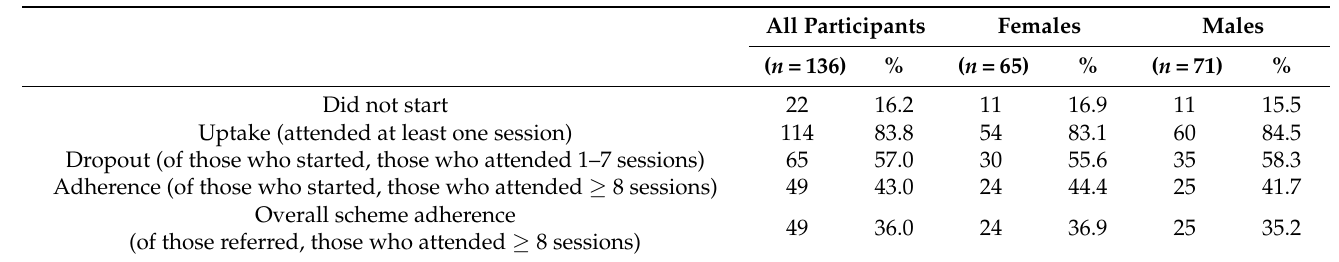
Table 4. Uptake, dropout and adherence.